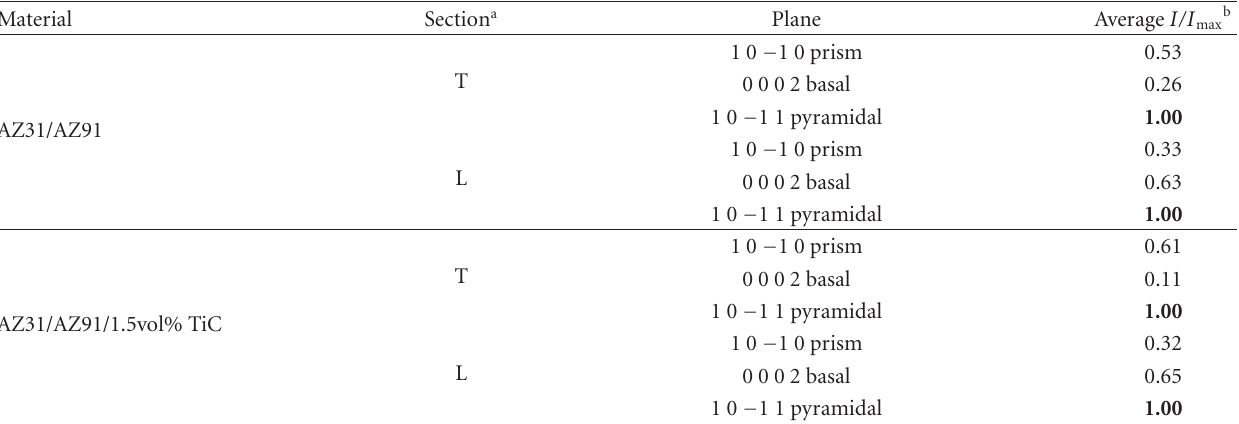
Table 2: Texture results of AZ31/AZ91 and AZ31/AZ91/TiC nanocomposite based on X-ray di ff raction.